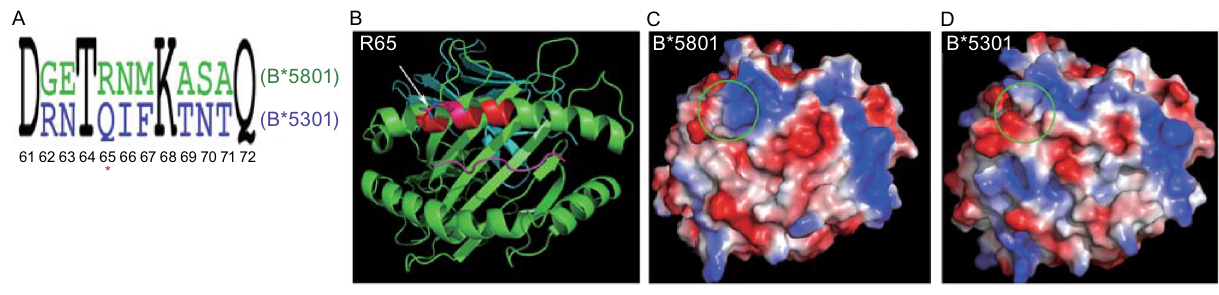
Figure 2. Comparison between HLA-B*5801 and HLA-B*5301 . (A) Sequence alignment of HLA-B*5801 and HLA-B*5301 (residues 61 – 72). Only eight residues differ between the two HLA molecules, and the residue R65 which contributes to the large positive area in HLA-B*5801 is labeled with a star. (B) Ribbon drawing of HAL-B*5801 molecule viewing down the peptide-binding groove from the TCR perspective. The distinct residues between HLA-B*5801 and HLA-B*5301 are in red region and cluster at the α 1-helical region of HLA molecule. The R65 is labeled and highlighted as sticker here. (C and D) Electrostatic potential surface representation in the same view as in the ribbon drawing in B, for HLA-B*5801 and HLA-B*5301 (PDB: 1A1M), respectively. The red color represents negative potential, the blue positive and the while color neutral. The most remarkable distinction between HLA- B*5801 and HLA-B*5301 is highlighted as